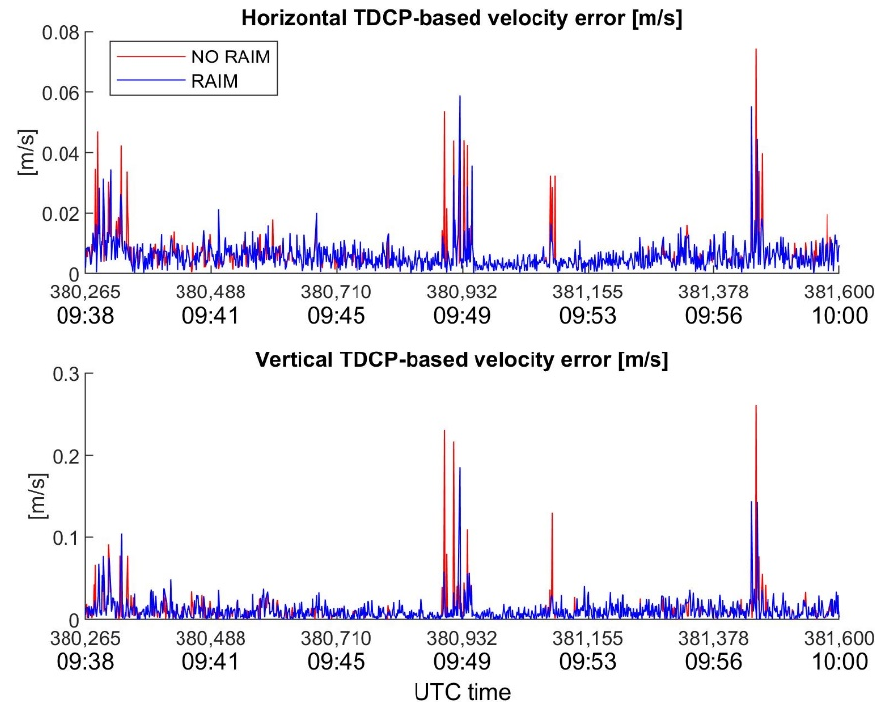
Figure 12. Xiaomi Mi8 horizontal and vertical TDCP-based velocity error as function of time, with and without RAIM application.